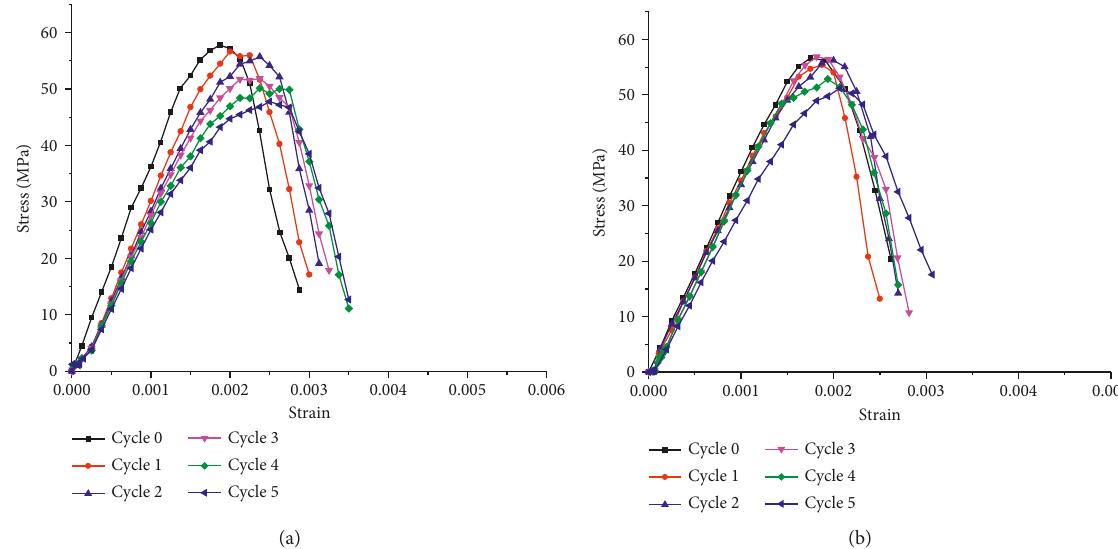
Figure 3: Stress-strain curves of C60 concrete. (a) Internal environment. (b) External